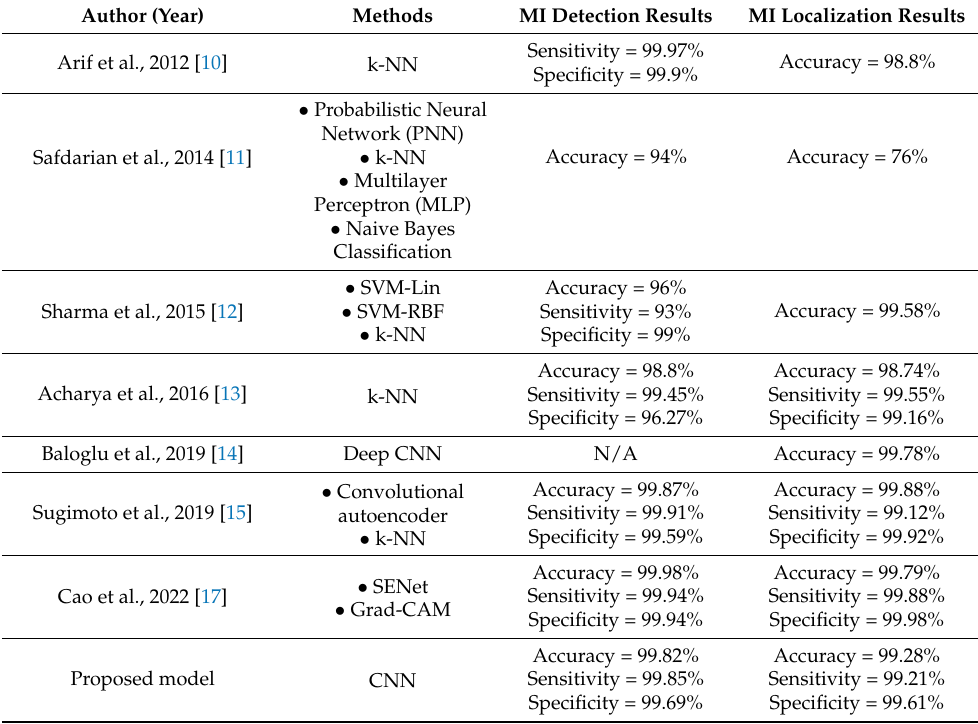
Table 9. Comparison of classification performance between proposed model and existing methods under Setting